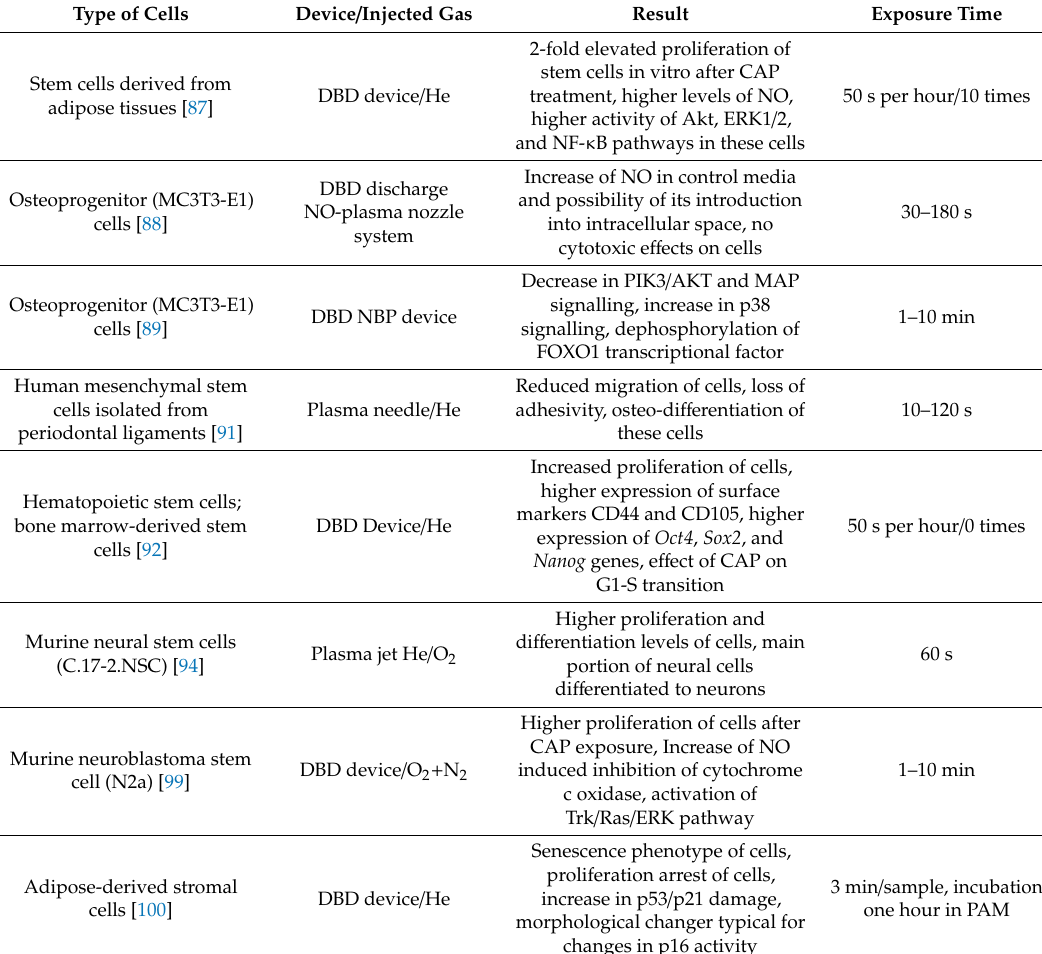
Table 4. List of CAP application e ff ects on stem cells and progenitor cells under in vitro conditions. Type of Cells Device / Injected Gas Result Exposure